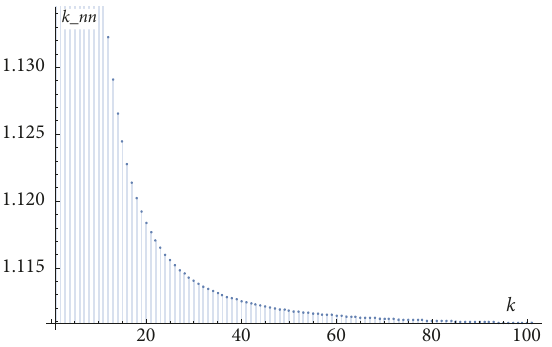
Figure 4: Function 𝑘 𝑛𝑛 for a disassortative network as in Section 3.4 with 𝛾 = 4 , 𝑛 = 101 ( 𝑁 ≃ 10 4